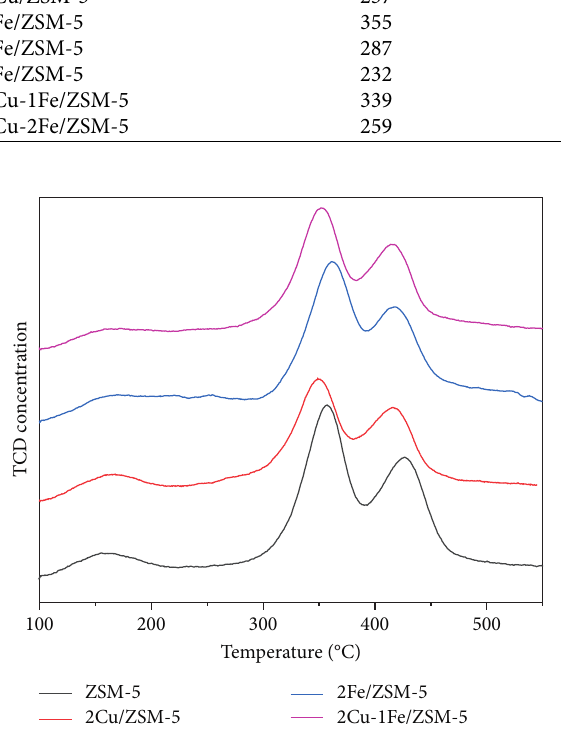
Figure 5: Temperature-programmed desorption of ammonia of catalysts. Table 3: Acidic properties of the